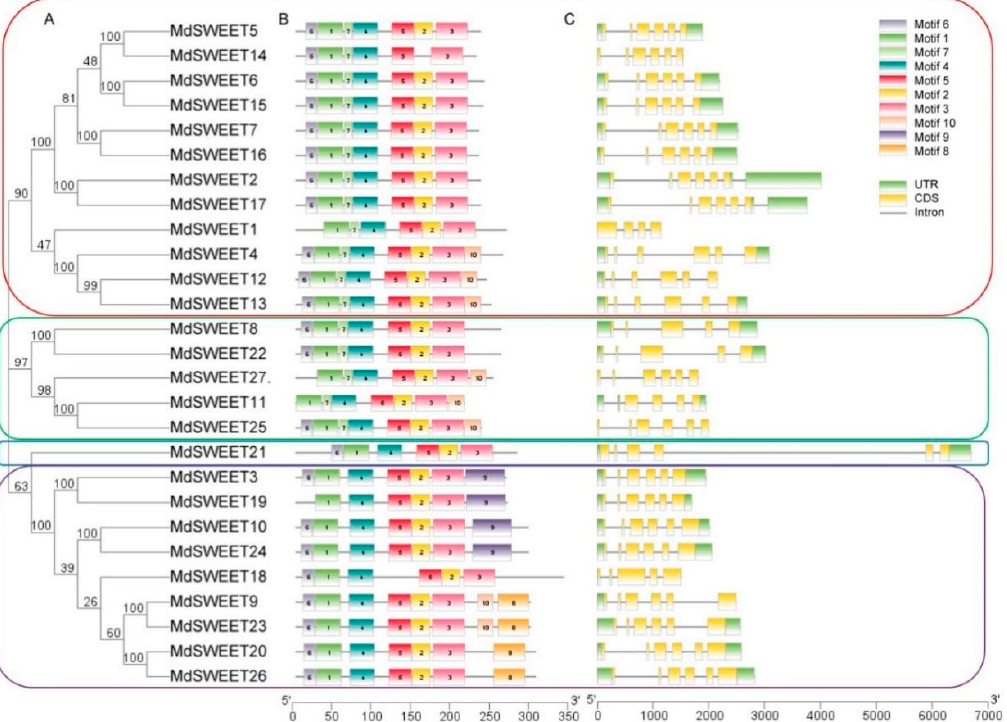
Figure 4. Analysis of conserved motifs and gene structure in the phylogenetic tree of the MdSWEET gene family. ( A ) Phylogenetic tree of MdSWEETs. Different clades are marked with different colors. Frames in red, green, purple, and blue indicate clades I, II, III, and IV. ( B ) Conserved motifs predicted in MdSWEET proteins. The conserved motifs were analyzed using MEME v5.4.1 (https://meme-suite.org/meme/tools/meme/ (accessed on 15 December 2020)), and the 10 motifs are represented by squares of different colors and numbered 1–10. ( C ) Exon–intron structures of MdSWEET genes. Yellow bars: exons; lines: introns; green bars: untranslated region.